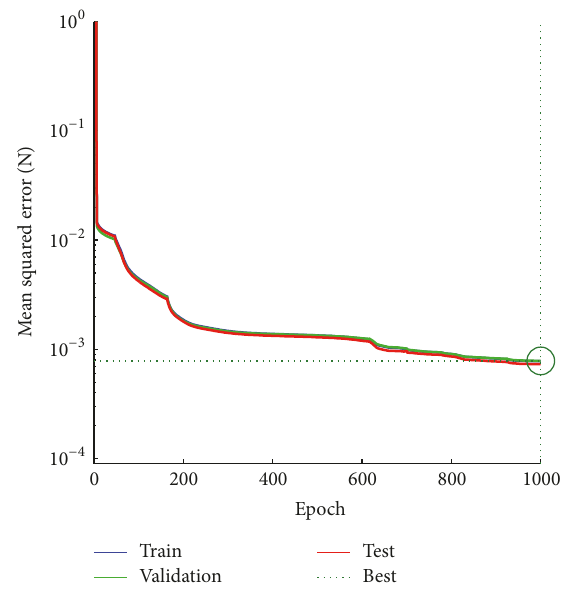
Figure 3: Mean squared